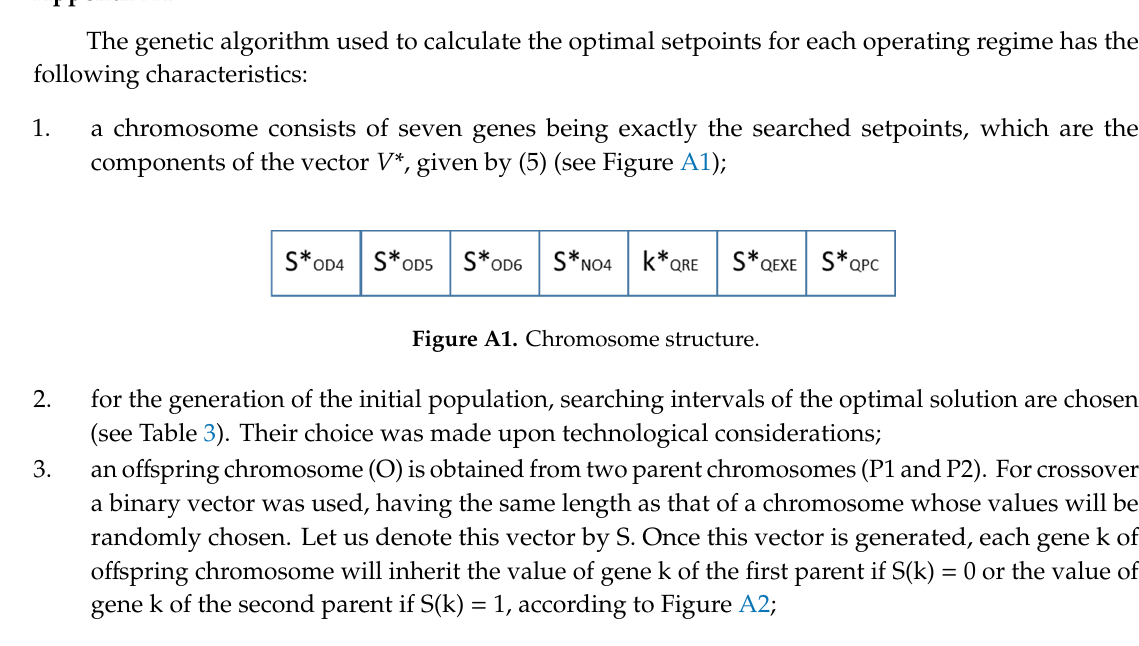
Figure A2. Crossover operation. 4.